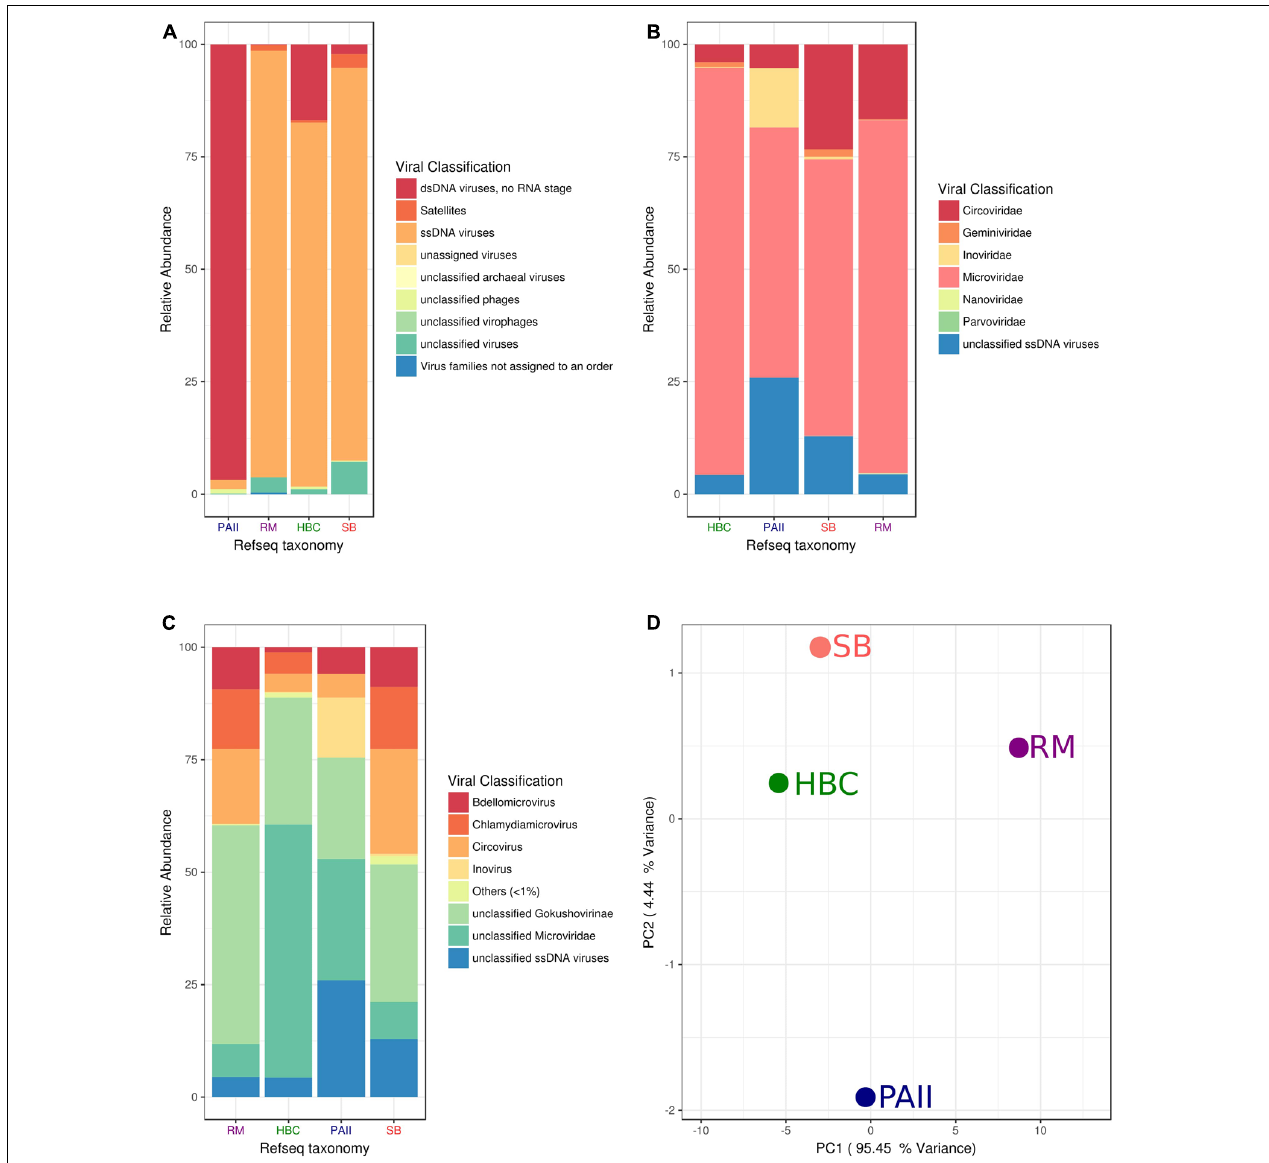
FIGURE 2 | Viral fraction comparison Shark Bay against Highbourne Cay, Rios Mesquites and Pozas Azules II microbialite sites. (A) Viral taxonomic classification characterization by nucleic acid state in MetaVir2. (B) Viral taxonomic classification characterization by viral family in MetaVir2. (C) Viral taxonomic classification characterization by viral genus in MetaVir2. (D) Principal coordinate analyses (PCA) comparing the viral diversity in disparate stromatolite locations. PCA were constructed from similarity matrices utilizing protein coding sequence recruitment using NCBI viral refseq database (refseq update 2017-1-11) and normalized to genome length using the built-in GAAS. Proportion variance (PC) was explained by each component printed next to the PC1/PC2 axes labels. MetaVir2 viral (BLAST) based comparison ( e -value ≤ 10 − 5 ) against NCBI viral refseq database and normalized to genome length using the built-in Genome-relative Abundance and Average Size (GAAS) normalization tool (Angly et al., 2006). MG-RAST Functional annotations using KEGG (KO) and SEED where based on BLAT based comparison ( e -value ≤ 10 − 5 ) against respective database. SB, Shark Bay; HBC, Highbourne Cay; PAII, Pozas Azule II; RM, Rio